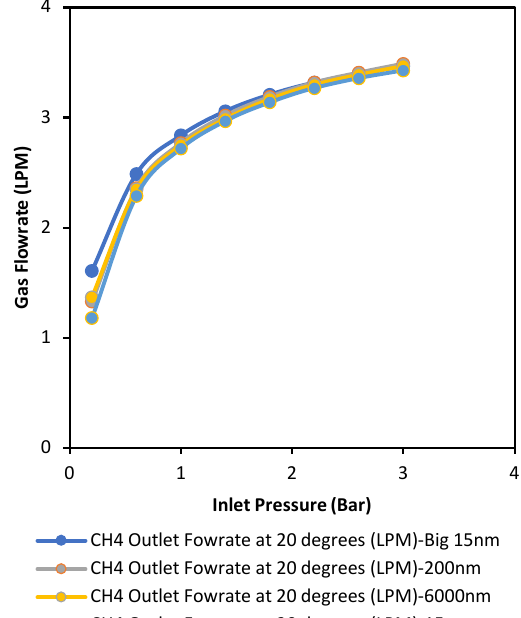
Figure 4. Isothermic effect of pressure on methane flowrate with each membrane at 20 °C.